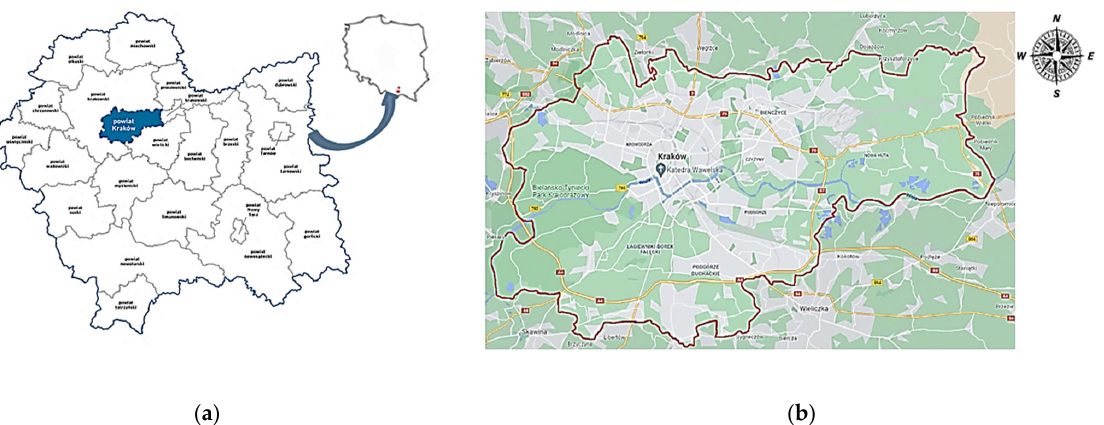
Figure 3 . Borders of the Krakow Agglomeration ( a ); Location of the Krakow agglomeration against the background of the Lesser Poland Voivodeship (Southern Poland) ( b ).